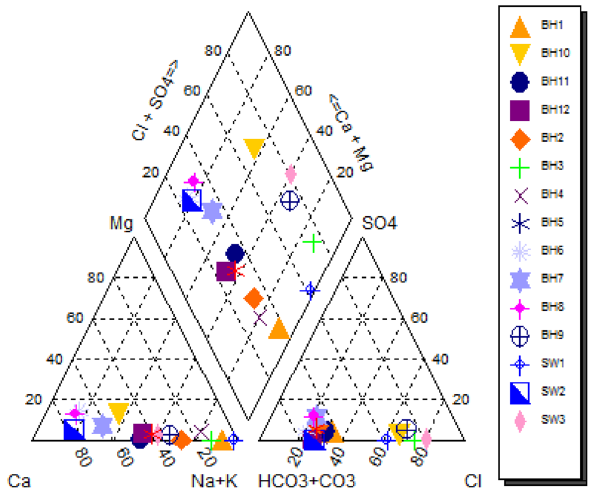
Fig. 6 Piper diagram plotted for the samples Fig. 7 Durov diagram plotted for the